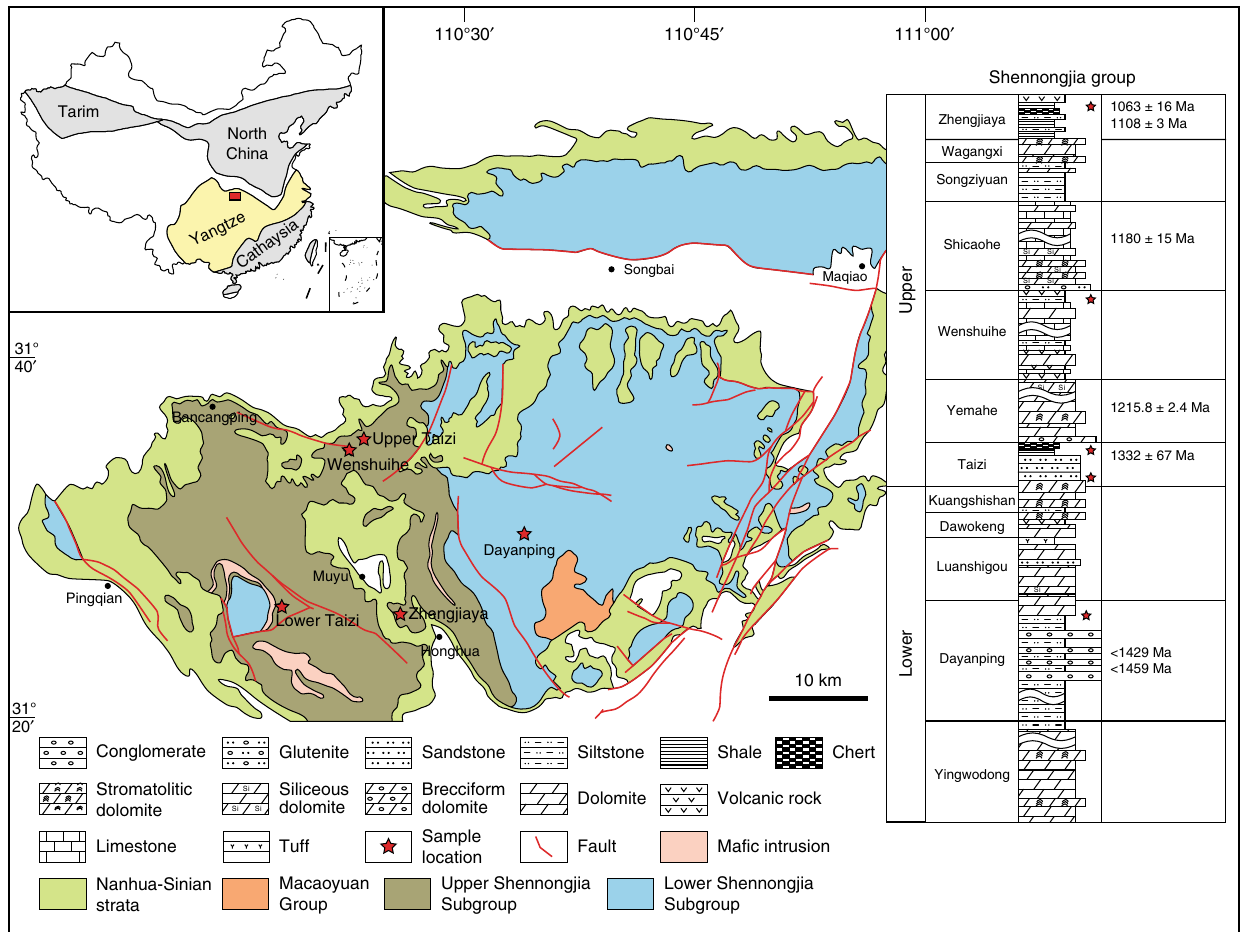
Fig. 1 Map of Shennongjia Group including major tectonic features and a general stratigraphic column with dating. Indicated also on the fi gure are sampling locations as well as an indication as to where in the stratigraphy the samples were taken. The fi gure is modi fi ed from ref. 32 with